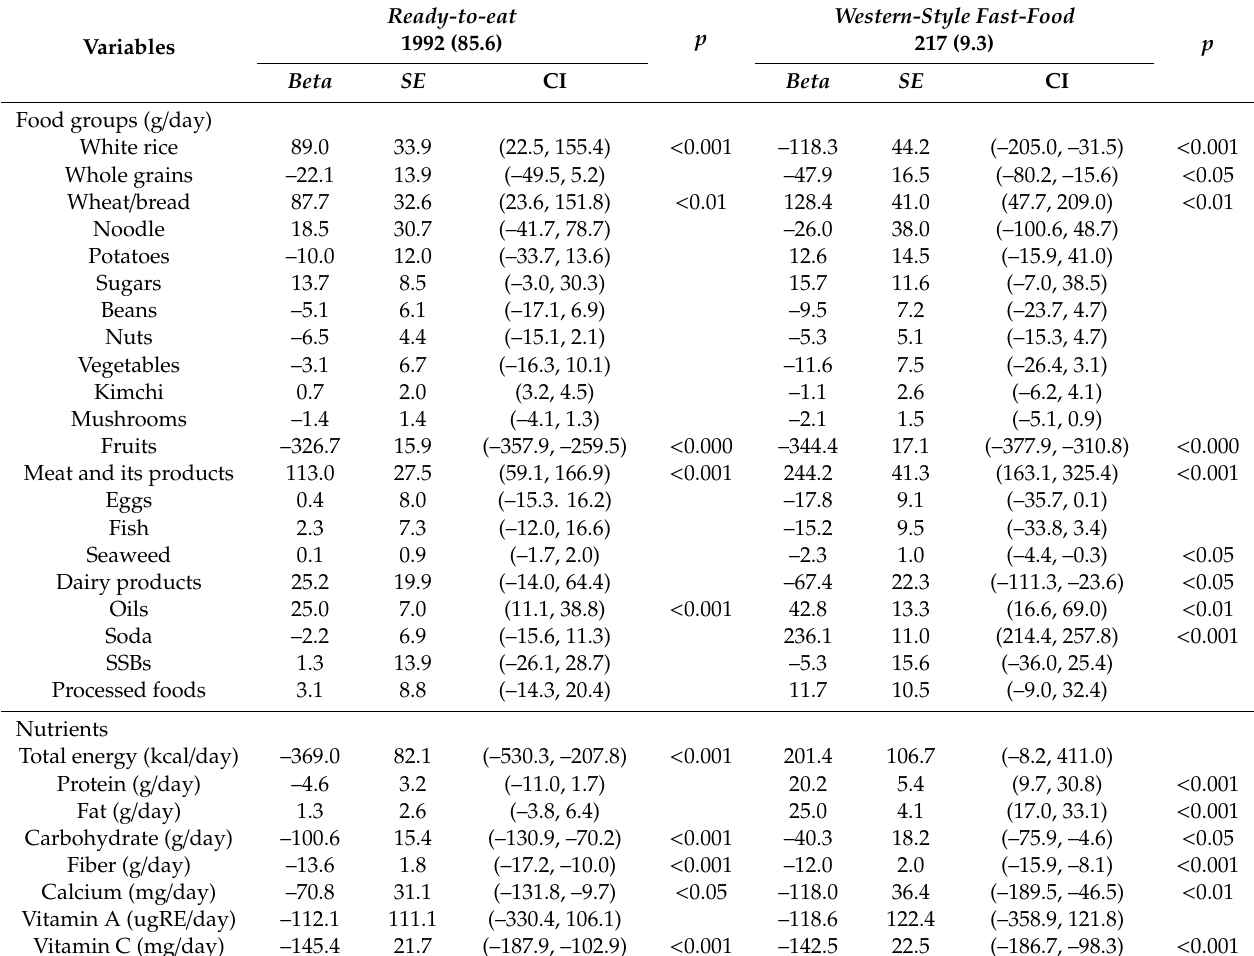
Table 3. Di ff erences in food intake of 10–18-year-old children and adolescents according to the three dietary